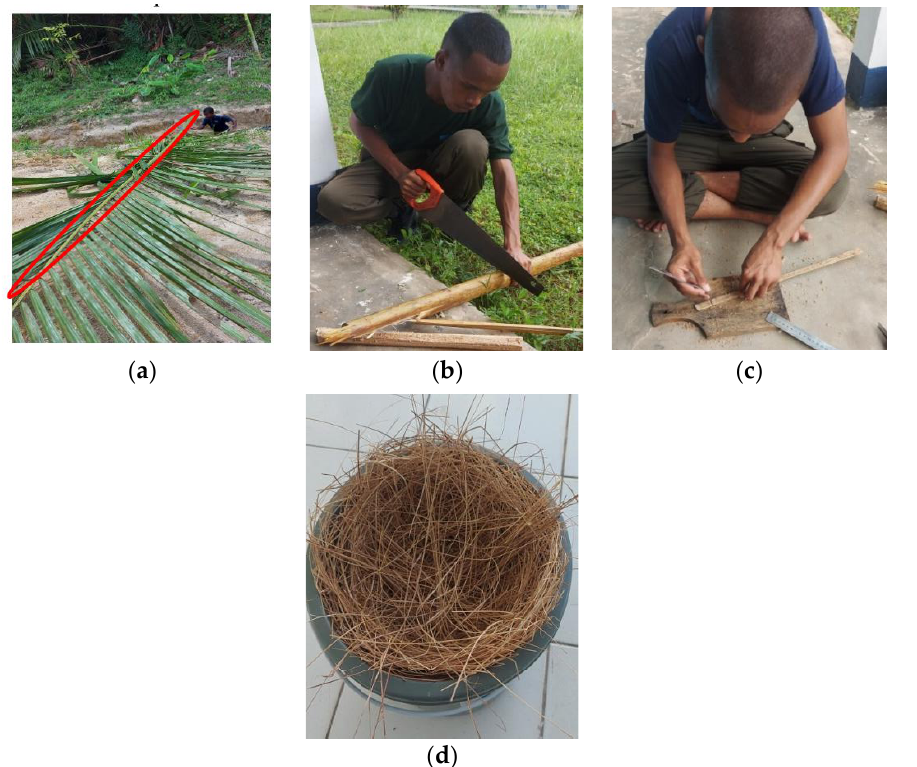
Figure 4. The process of obtaining sago midrib fiber material: ( a ) separation of the leaf from the midrib; ( b ) cutting the sago midrib; ( c ) separation of pith from the fiber; and ( d ) sago midrib fiber. Table 1. The material properties of epoxy resin type BQTN-EX 157.